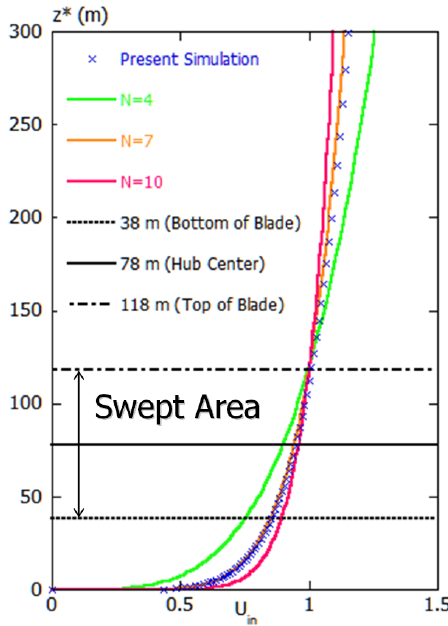
Figure 10. Inflow condition. U in : the inflow streamwise wind velocity at the height of the maximum surface elevation in the computational domain; z* (m): the height above the ground.